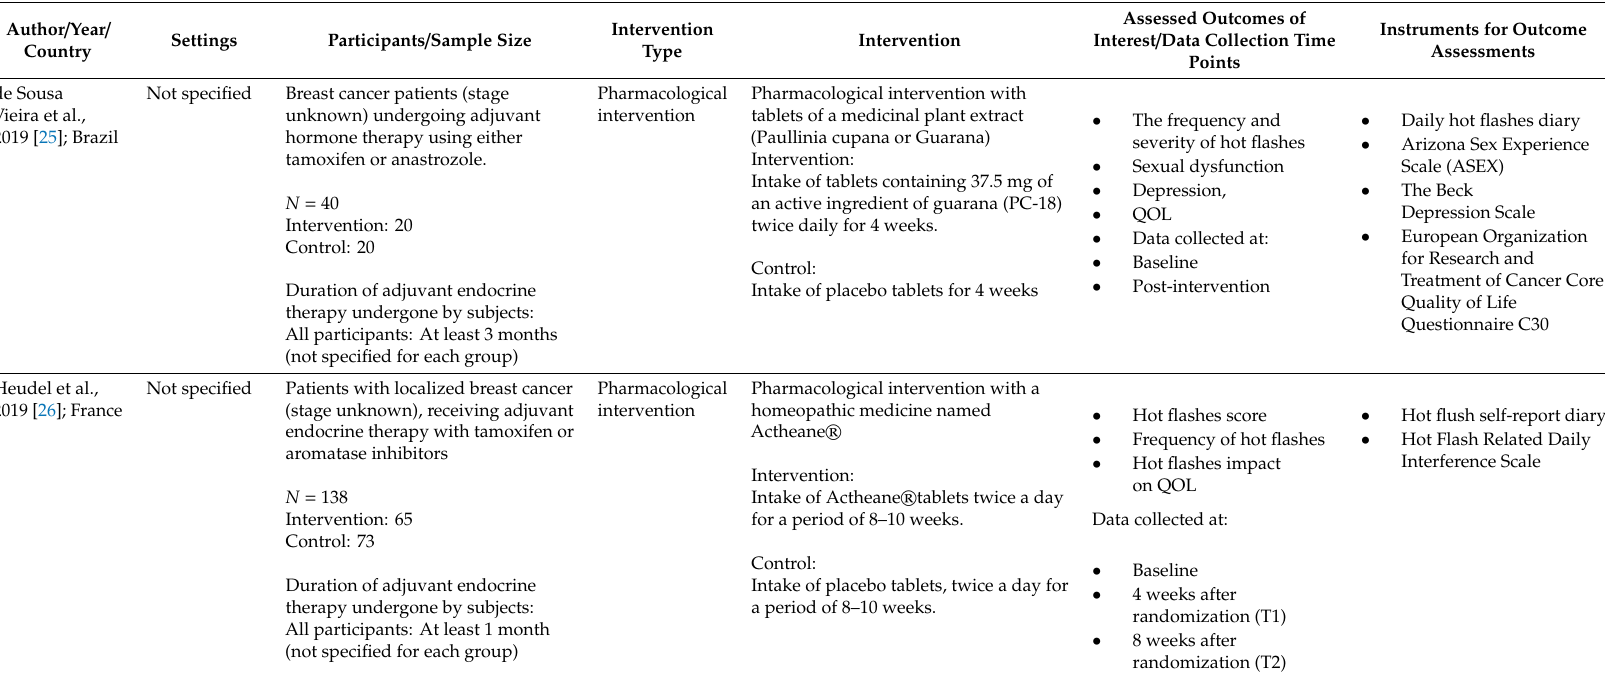
Table 3. Characteristics of the included